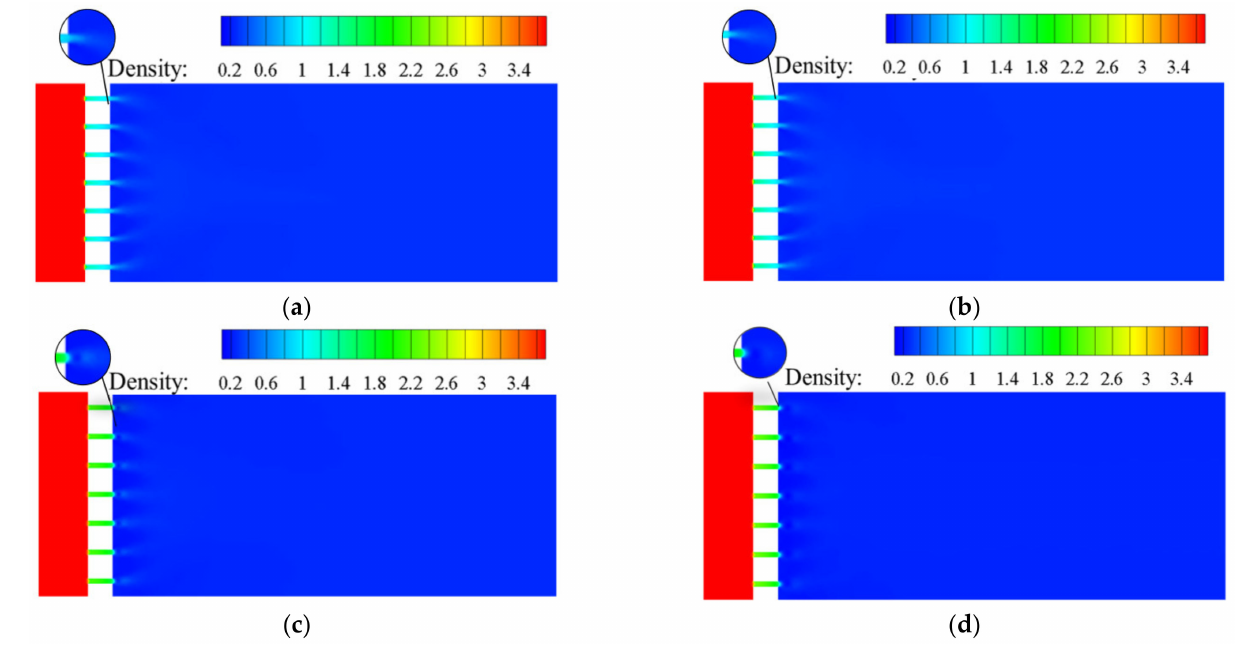
Figure 7. Density distribution on the symmetry plane for conventional orifice plate structure un- der different mass flow rates (density in kg m − 3 ). ( a ) Q m = 0.02 kg s − 1 . ( b ) Q m = 0.1 kg s − 1 .